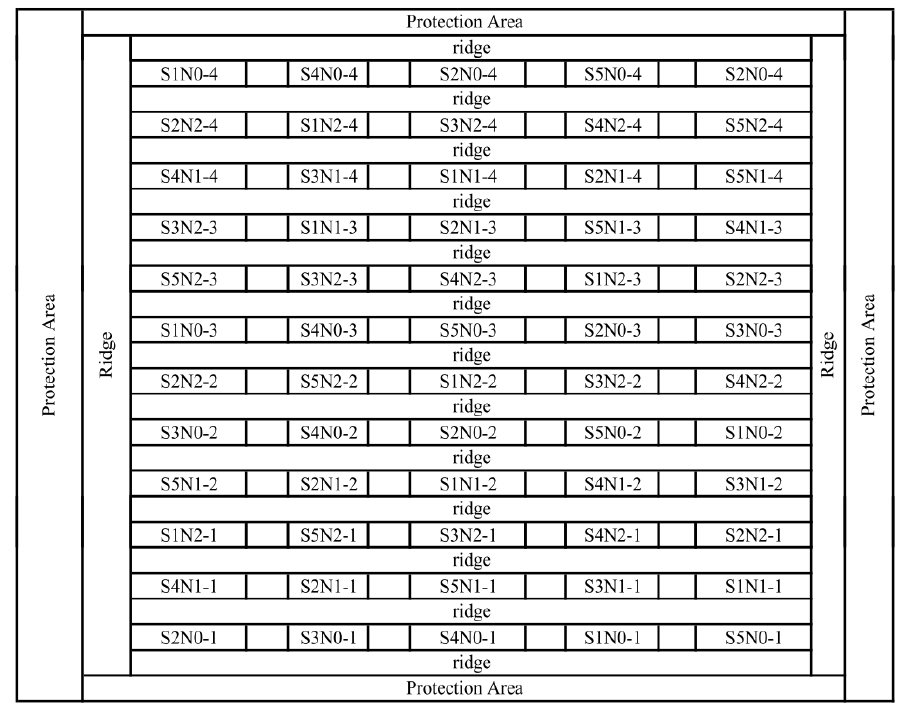
Figure 1. Field plot configuration of the paddy rice experiment for different nitrogen levels and species in 2002. S1, S2, S3, S4, and S5 represent Xiushui 110, Jiayu 293, Jiazao 312, Z00324, and Xieyou 9308, respectively. N0, N1, and N2 represent 0 kg·ha −1 , 140 kg·ha −1 , and 240 kg·ha −1 of pure nitrogen,